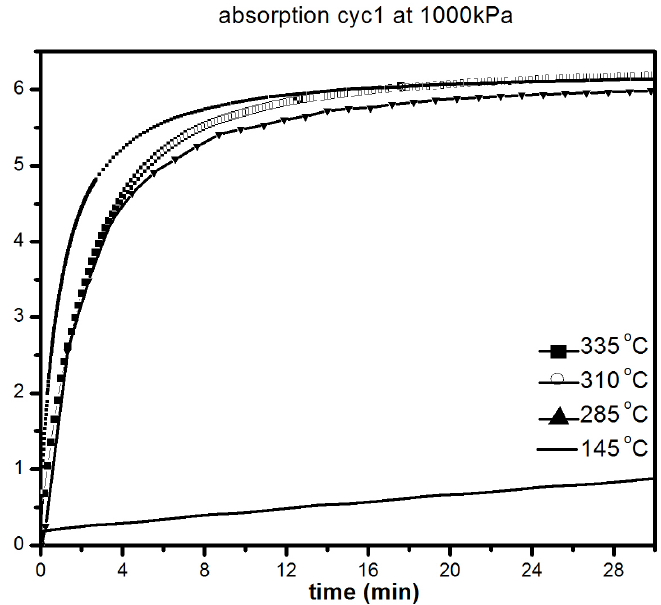
Figure 7. First absorption under 1000 kPa H 2 at different temperatures of 1 h milled MgH 2 + 5 mol% MgF 2 . The insert is a compete absorption curve at 145 °C.